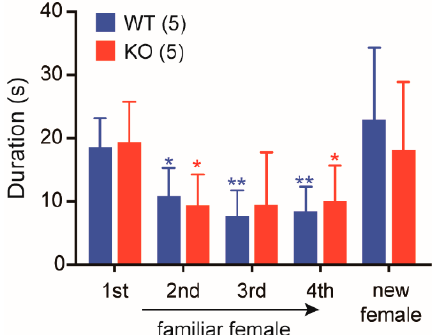
Figure 8. Normal social memory / recognition in Cth − / − male mice. Social memory / recognition by wild-type (WT) and Cth − / − male mice was evaluated by duration time (s) spent for anogenital investigation of unfamiliar females during 1st to 4th 1 min-trials with 10-min intervals. A 5th “dishabituation” trial depicts the response of males to the presentation of a new female. Data are represented as mean ± SD ( n in parentheses) and the di ff erences versus 1st trial were significant in * p < 0.05 and ** p < 0.01.